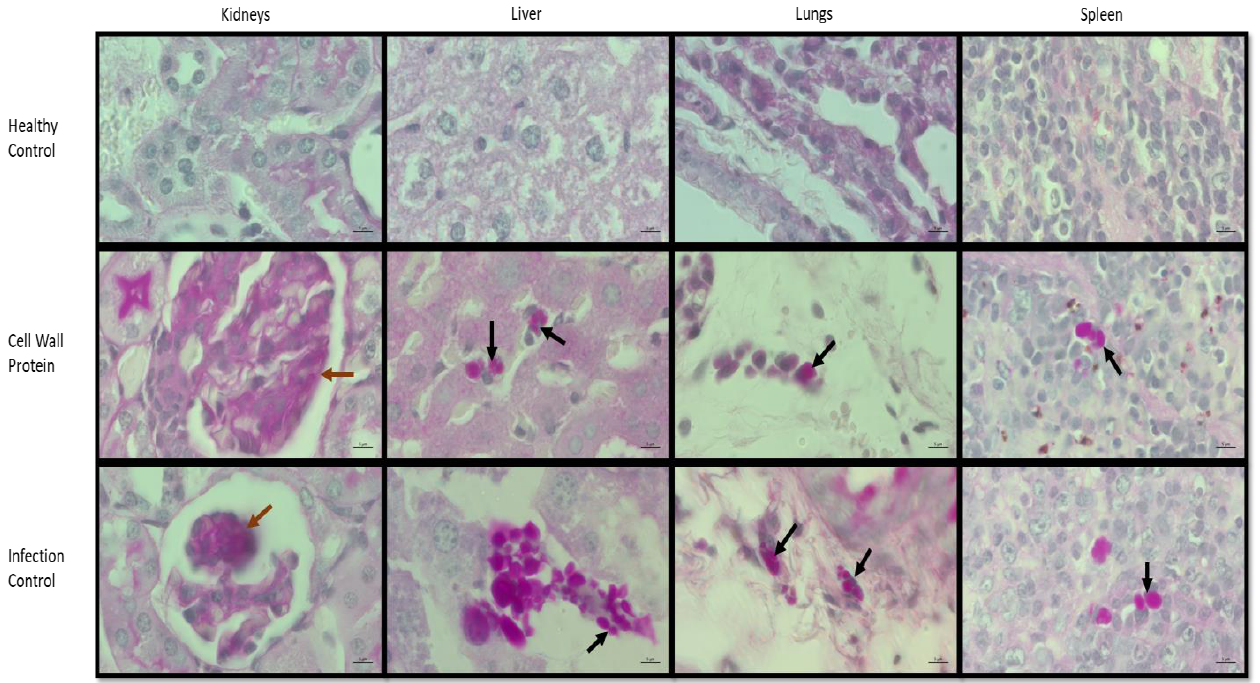
Figure 4. Comparative analysis of histopathology of different tissue sections from healthy control, immunized, and C. parapsilosis -infected mice after 48 h. Tissue sections recovered post infections were stained with PAS. The mouse from the infection control group displayed a higher fungal burden. While the cell wall protein immunized mouse showed significantly reduced fungal burden. The black arrows indicate of C. parapsilosis cells in the target tissues while the brown arrows indicate the damages in the